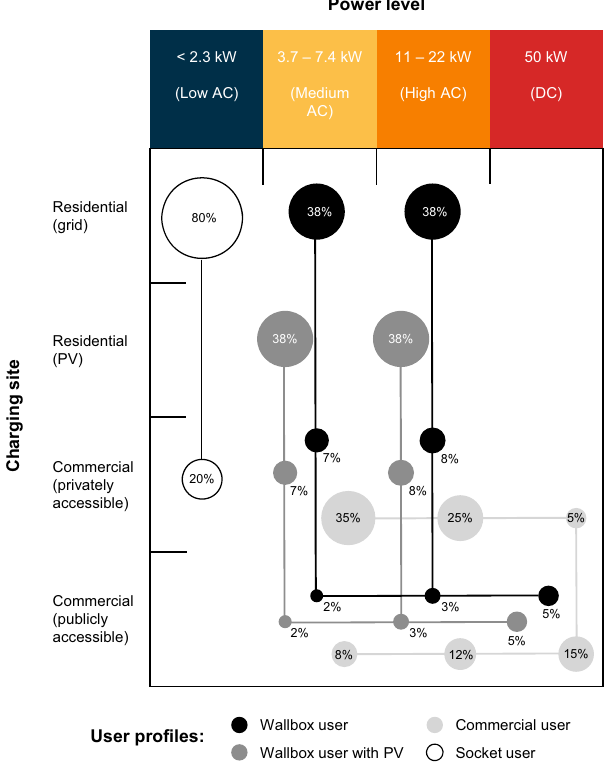
Fig. 1 | Matrix ofcharging options with charging shares (in terms ofenergy) of four characteristic user pro fi les. A range of power levels and charging sites are differentiated in a four by four matrix. Each combination of power level and char- gingsitegivesachargingoption.Weintroducefouruserpro fi lesthatarede fi nedby combinations of percentage charging energy shares at different charging options: Wallbox user, Wallbox user with PV, Commercial user and Socket user. Percentage energy shares of each charging option for a given user pro fi le are proportionally sizedwithbubbles.Shareswithinasingleuserpro fi lesumupto100%andarelinked. Refer to Supplementary Table 15 for speci fi c user pro fi le shares. Note that the Average user is not shown here for better fi gure clarity, but can be found in Sup- plementary Table 15 and Supplementary Fig. 5. Reading example: The user pro fi le Socket user describes an EV owner that charges 80% of the total charging energy at <2.3kW from the residential grid and 20% at <2.3kW from a privately accessible commercial station (e.g. at work). Source data are provided as a Source Data fi